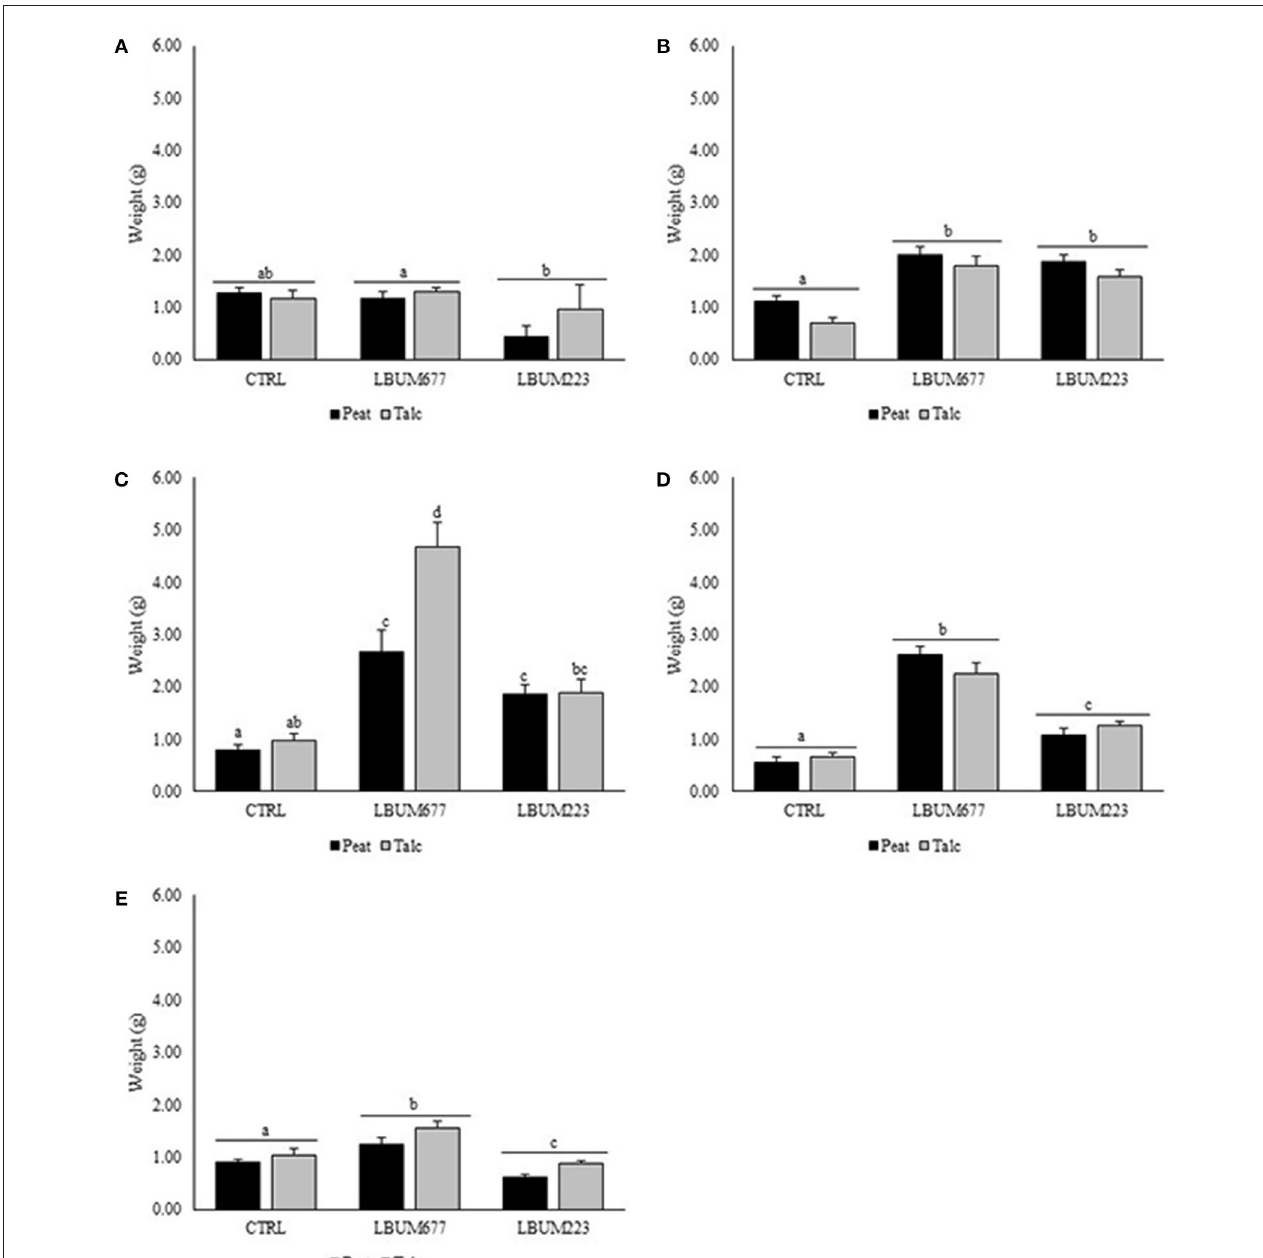
FIGURE 1 | Total plant fresh weight (in grams) of corn gromwell inoculated with peat or talc bioformulations of LBUM677, LBUM223, or control that were stored for (A) 30 days, (B) 60 days, (C) 90 days, (D) 120 days, and (E) 180 days. All plants were harvested at the same age and destructively sampled at the same development stage (after 60 days of growth). Black bars represent bioformulations prepared with peat while gray bars represent bioformulations prepared with talc. Different letters indicate statistically significant differences between